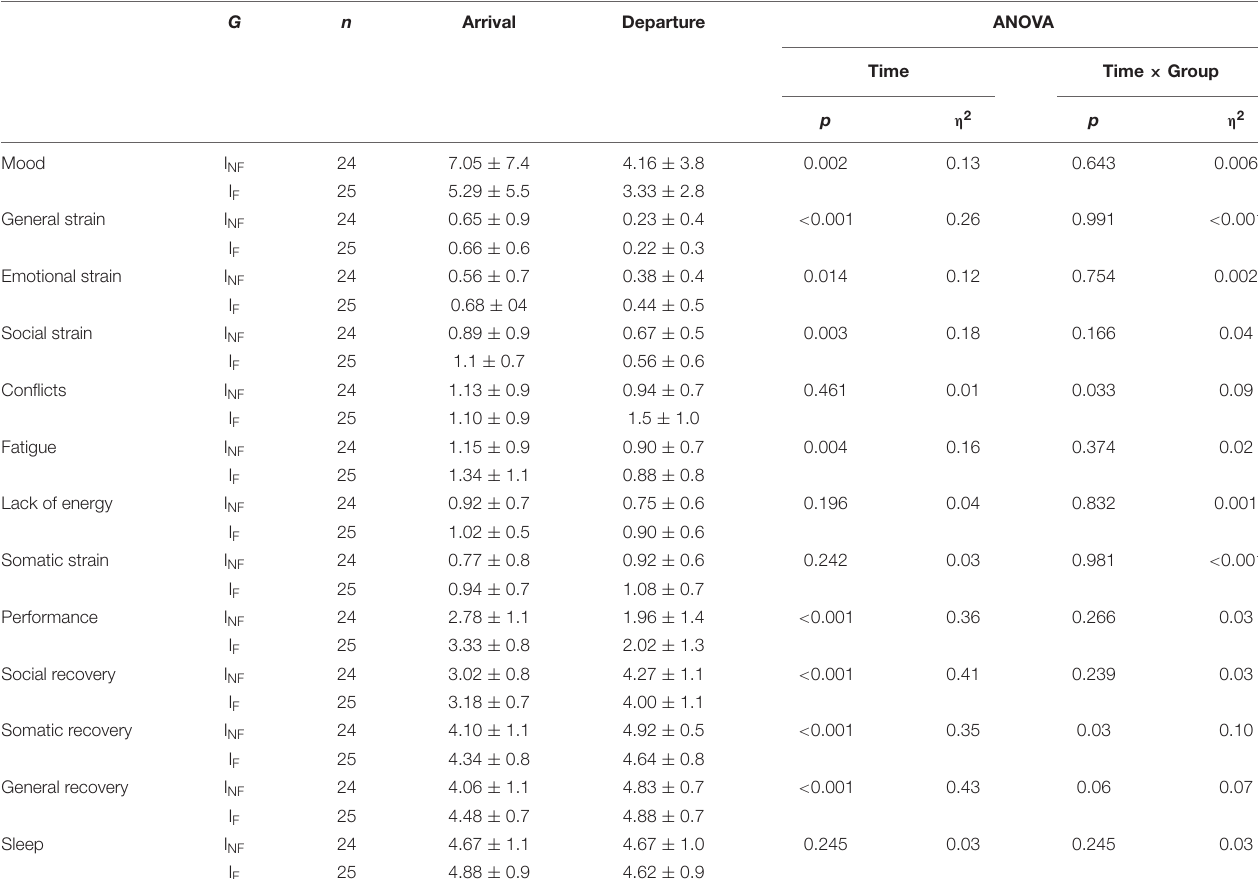
TABLE 5 | Subjective mood and well-being. G n Arrival Departure ANOVA